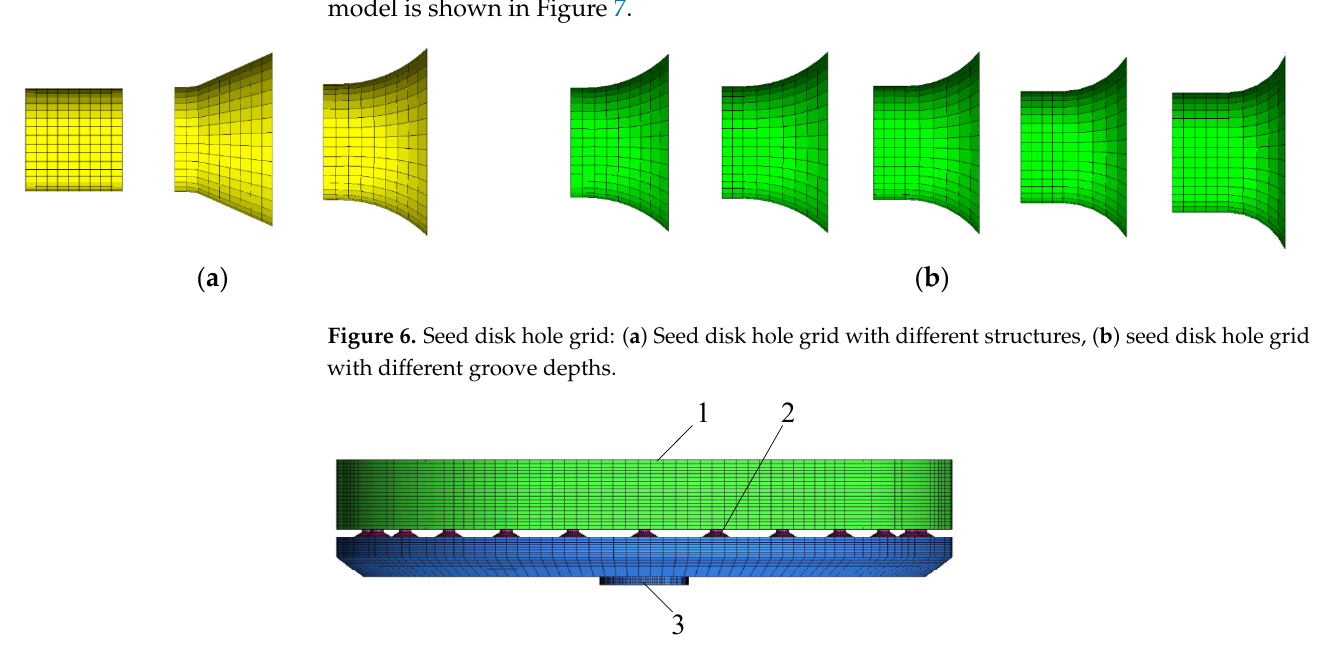
Table 3. Simulation parameters. Parameter Maize Organic Glass